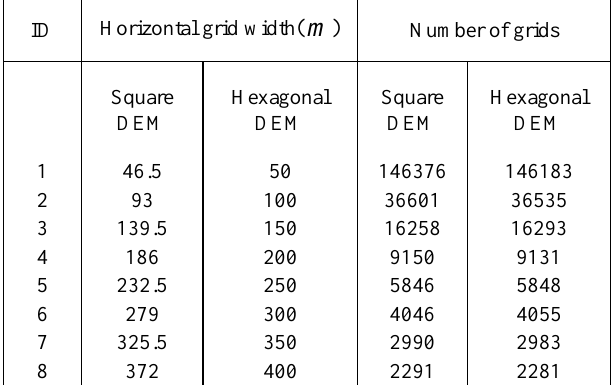
Table 1. The horizontal grid width and the number of grids